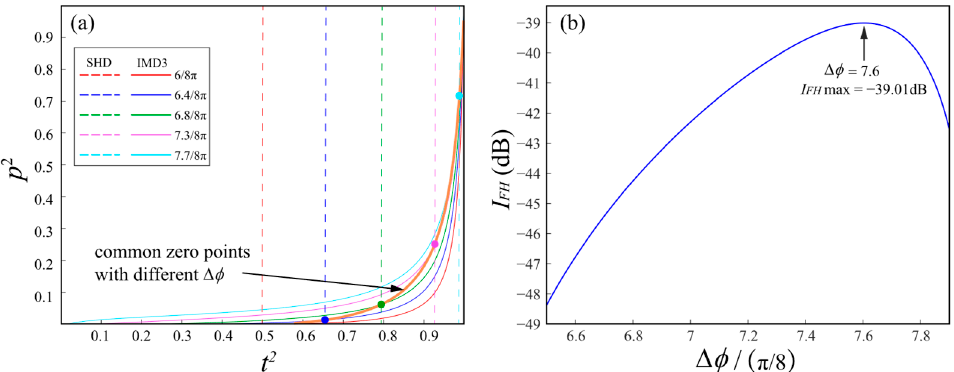
Figure 4. ( a ) The zero points of SHD and IMD3 with different ∆ φ s. The orange line is the common zero points with different ∆ φ . ( b ) The I FH as a function of ∆ φ .